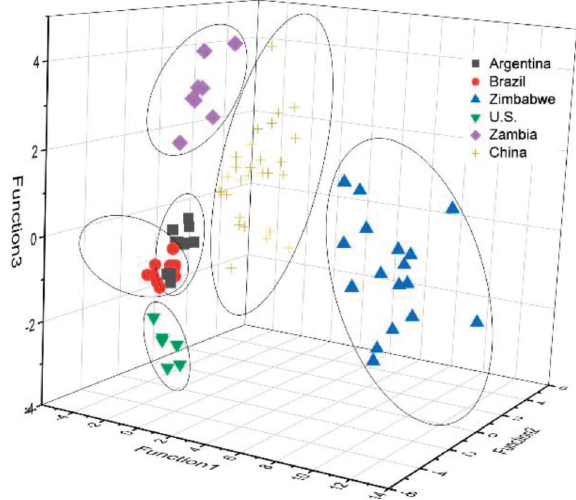
Figure 14: The 3D score plots of tobacco samples on the first three discriminant